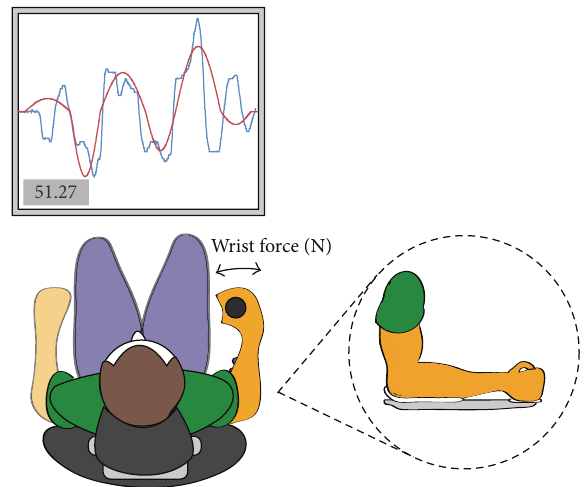
Figure 2: Illustration of the setup for the visuomotor accuracy tracking task (VAT). Subjects were seated at a table in front of a computer screen with their right forearm secured in a custom made setup. A red target trace appeared on the screen and a blue trace cursor moved from left to right with a constant velocity. The handle translated medial and lateral torque force into a deflection of the cursor trace either up or down. Subjects were instructed to follow the target trace as closely as possible. A motor performance score was presented at the completion of each trial during motor